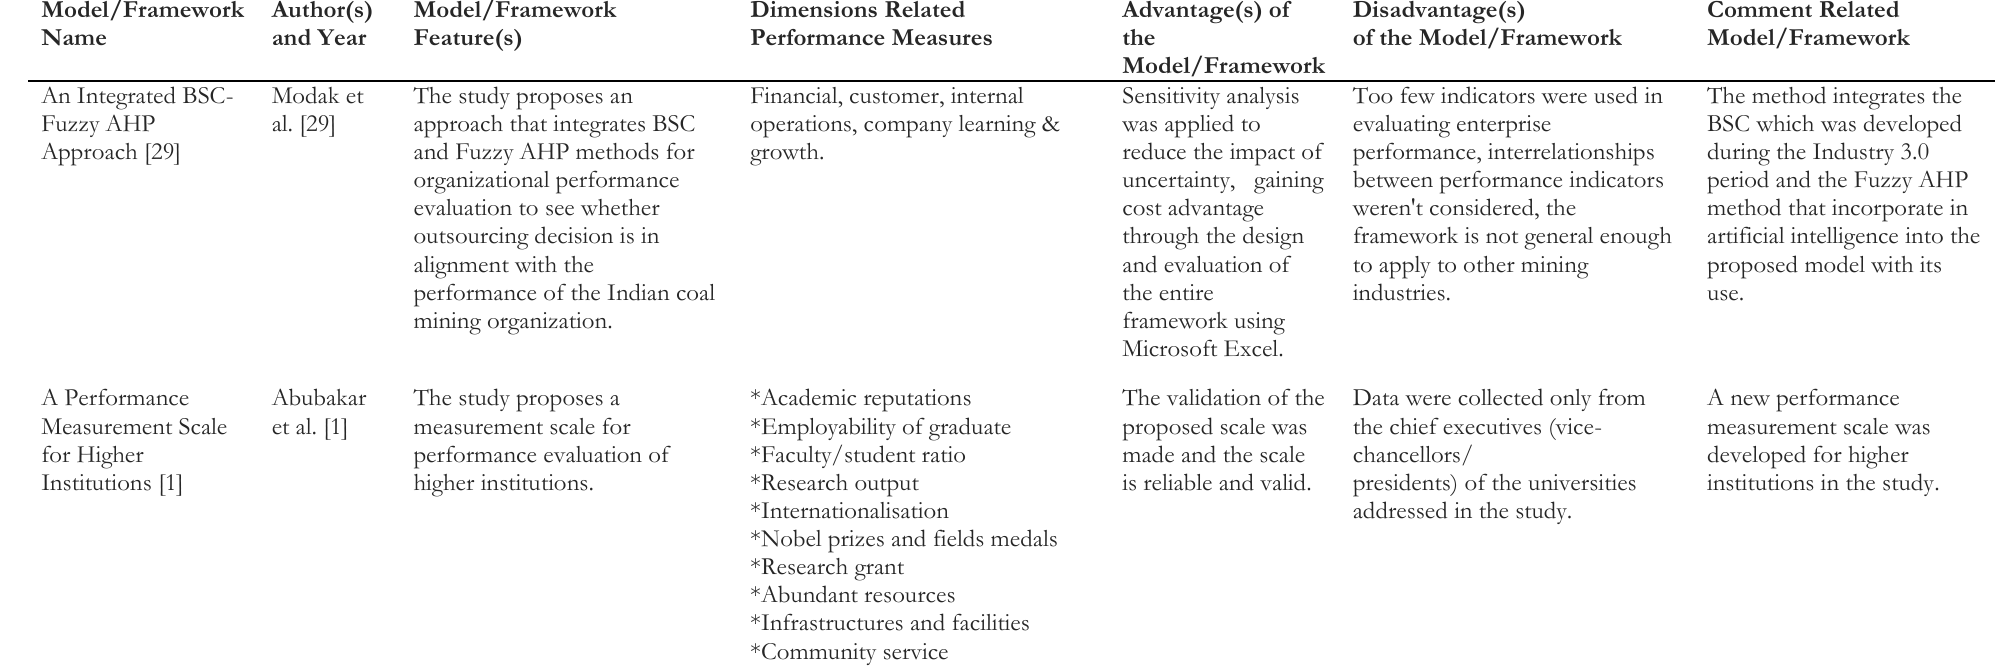
Table 5. Organizational performance measurement models developed in Industry 4.0.